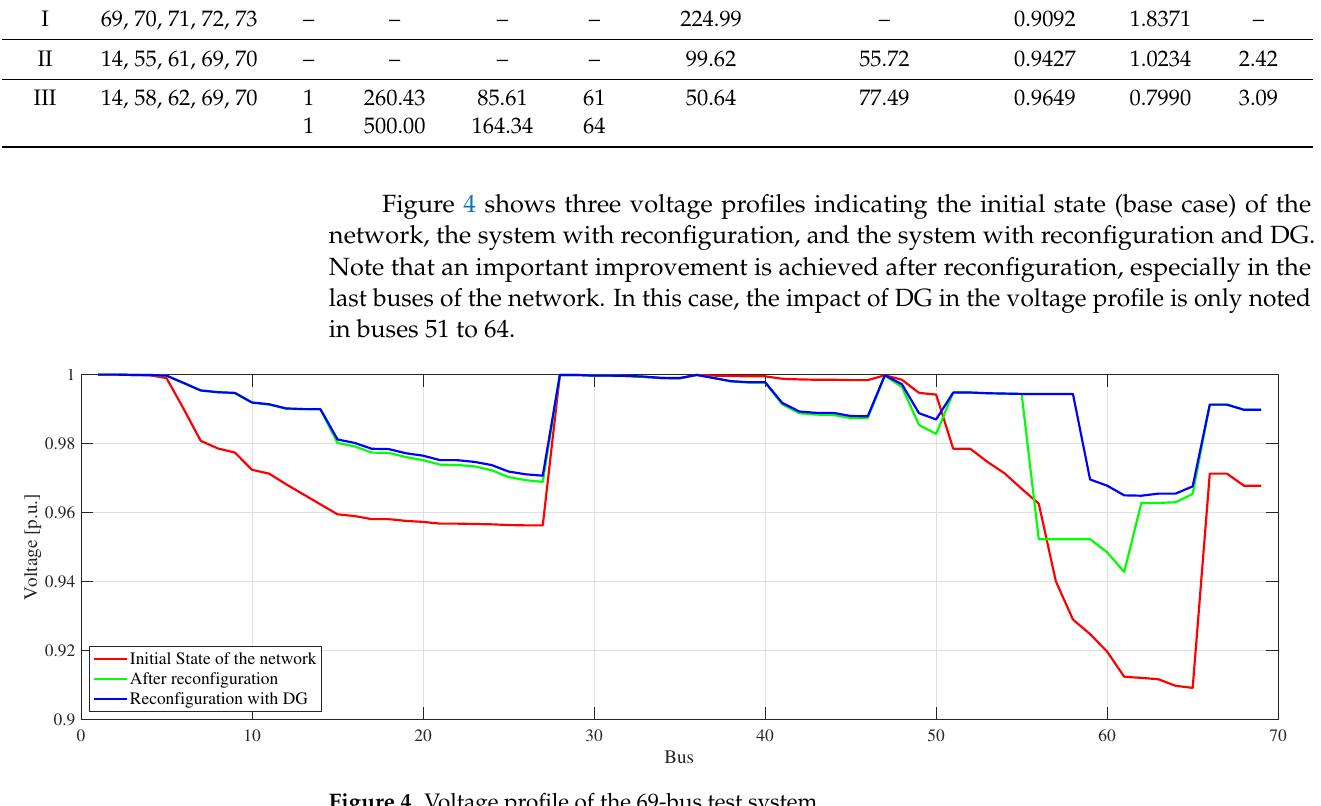
Figure 4. Voltage profile of the 69-bus test